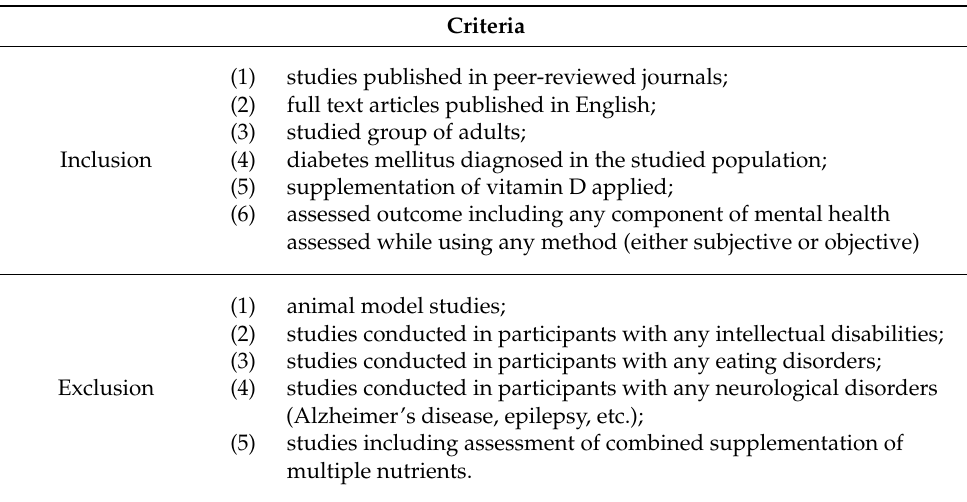
Table 1. The inclusion and exclusion criteria for the systematic